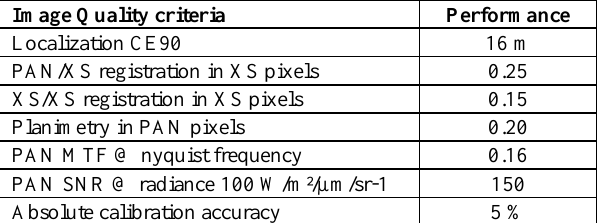
Table 1. Main Image Quality performance assessed April 5,